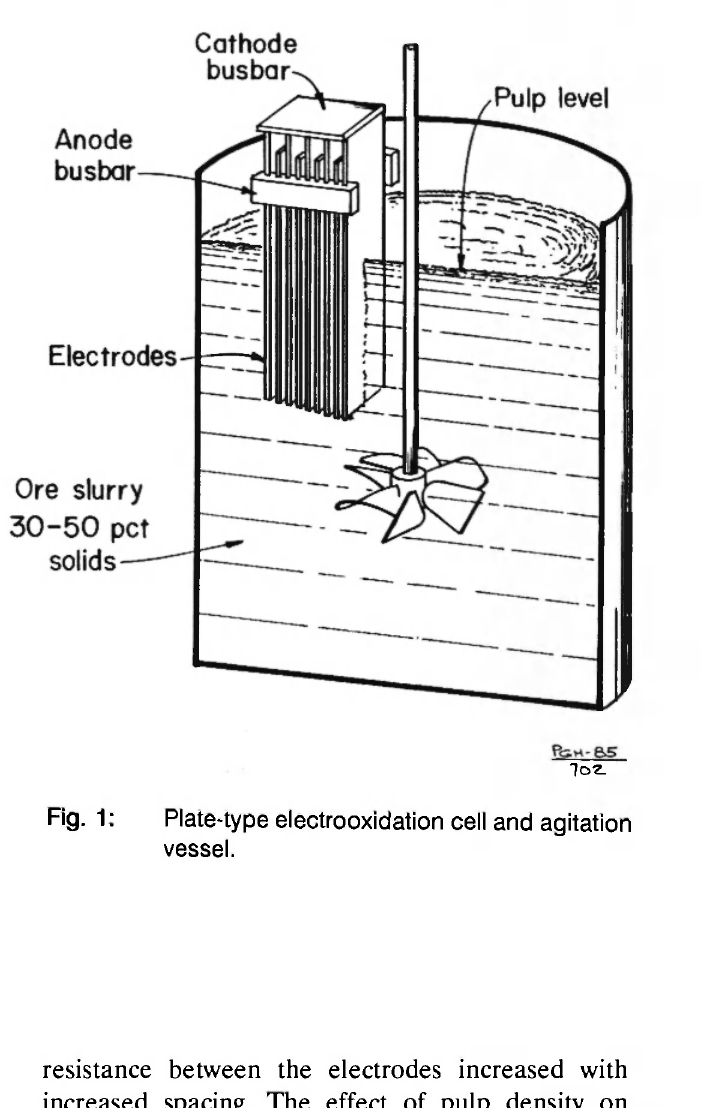
Plate-type electrooxidation cell and agitation